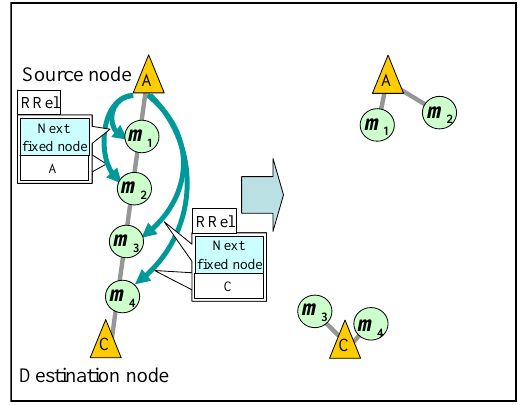
Figure 9. Release a communication